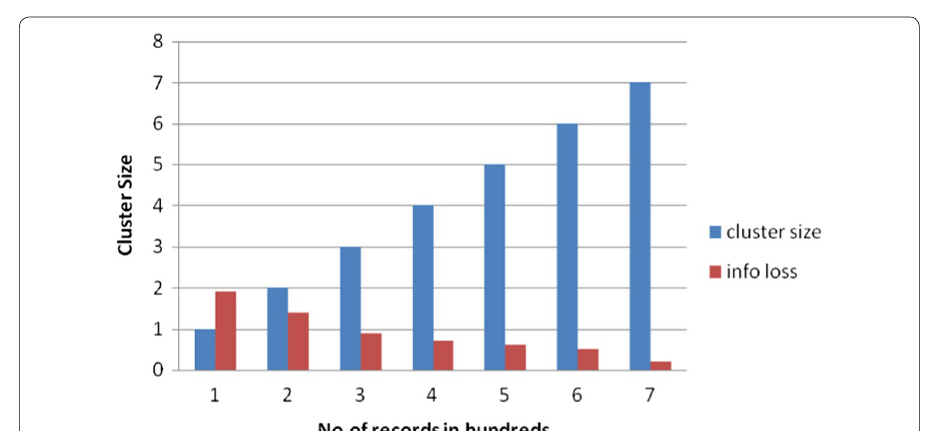
Fig. 13 Variation of informtion loss with increase in cluster